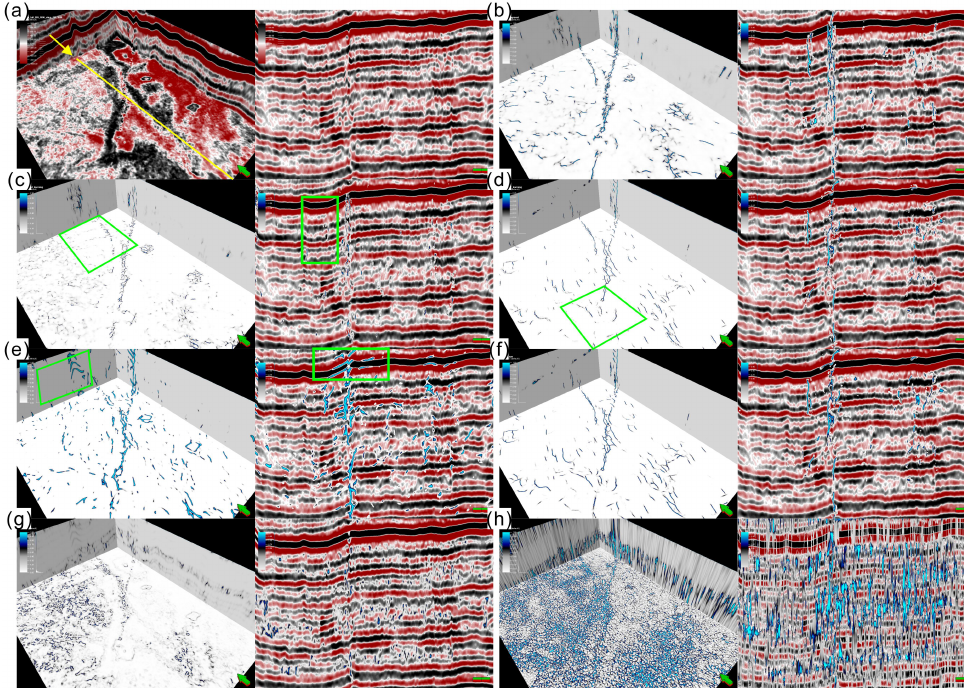
Figure 12. Fault recognition results of work area C. ( a ) Field seismic data. The yellow line represents the position of the detailed slice. ( b ) Detected faults by our structural data augmentation